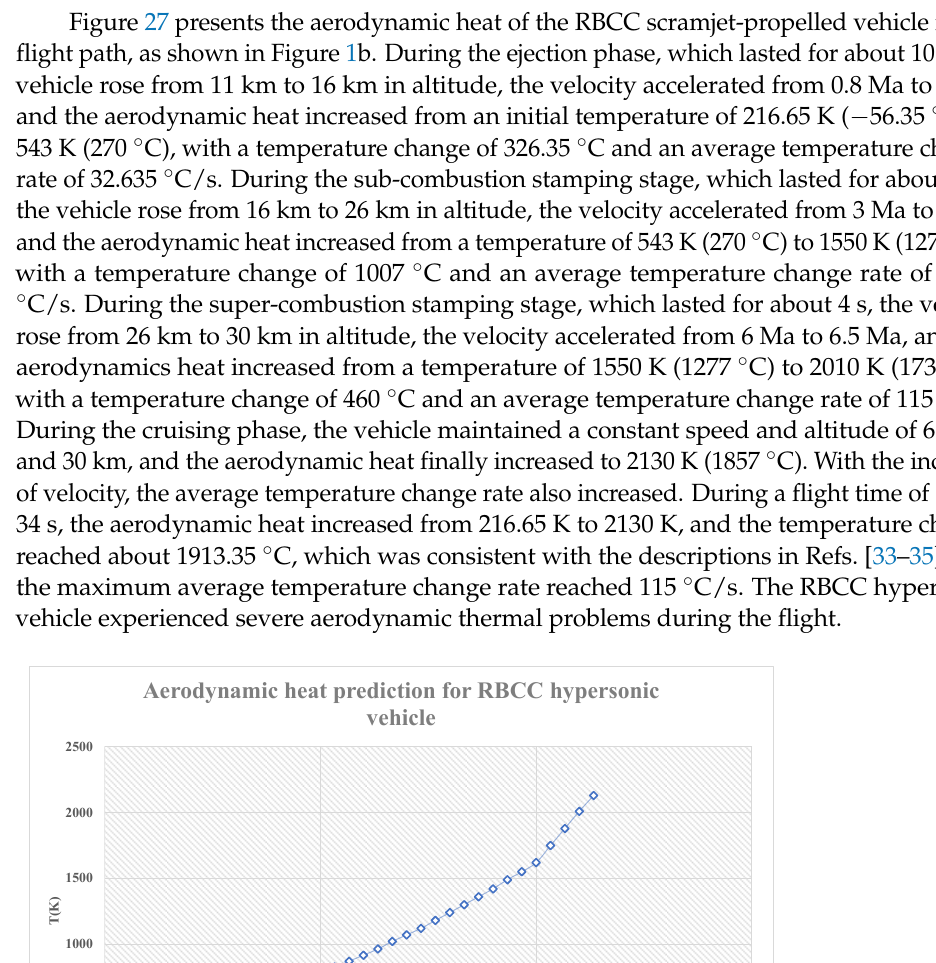
Hypersonic stage Mesh with 𝑦 (cid:2878) is 0.7, cell Reynolds number of 40 and aspect ratio of 40, turbulence model applying Spalart– Allmaras and density-based